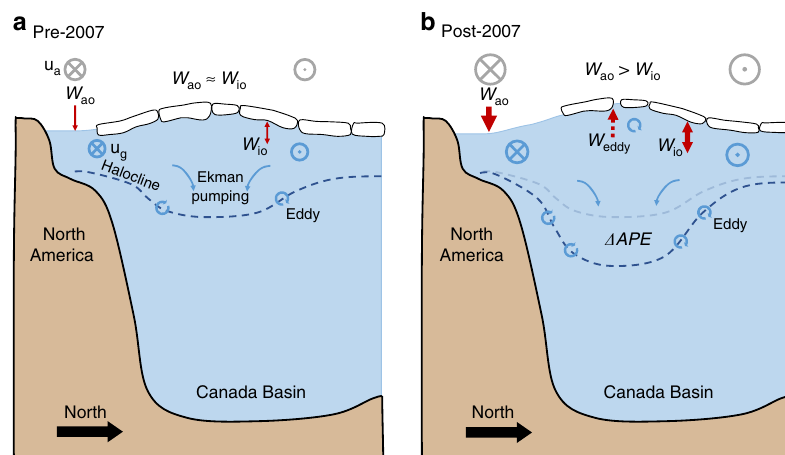
Fig. 5 The changing components of the Beaufort Gyre energy budget. a Before and b after 2007, including the wind work, W (comprised of atmosphere- ocean, W ao , and ice – ocean, W io , components), available potential energy (APE), and eddy dissipation, W eddy . The atmosphere and ocean circulations are illustrated by u a and u g , respectively. The size of the arrows/vectors represents their relative strength. The loss of sea ice after 2007 led to increased wind energy input to the BG, increased APE, and increased energy dissipation and freshwater stabilization by